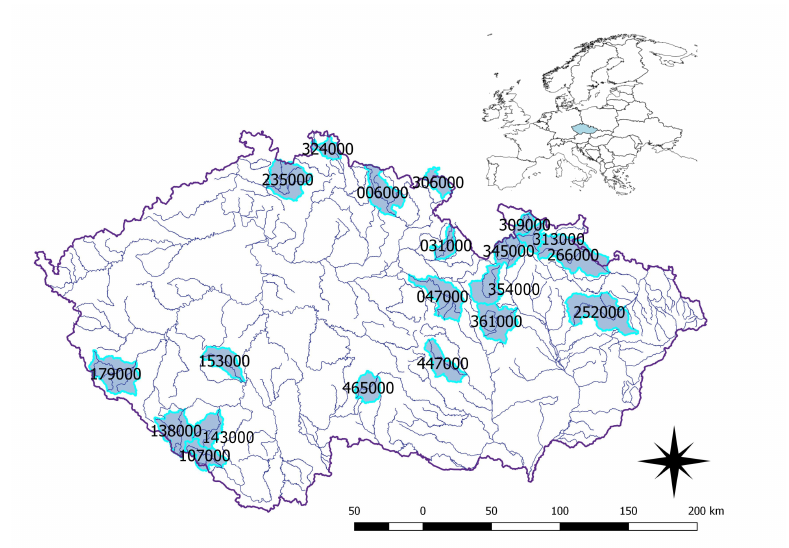
Figure 1. Evaluated